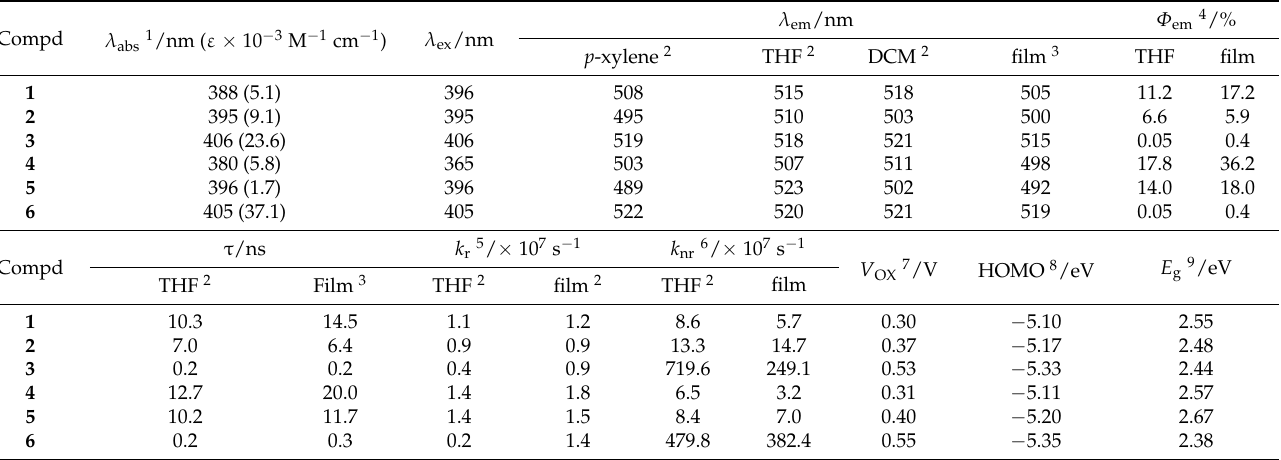
Figure 2. UV − vis absorption (left) and PL (right) spectra in THF (50 µ M) of the dimeric indium complexes ( a ) 1 – 3 and ( b ) 4 – 6 . Table 1. Photophysical and electrochemical results of 1 – 6.